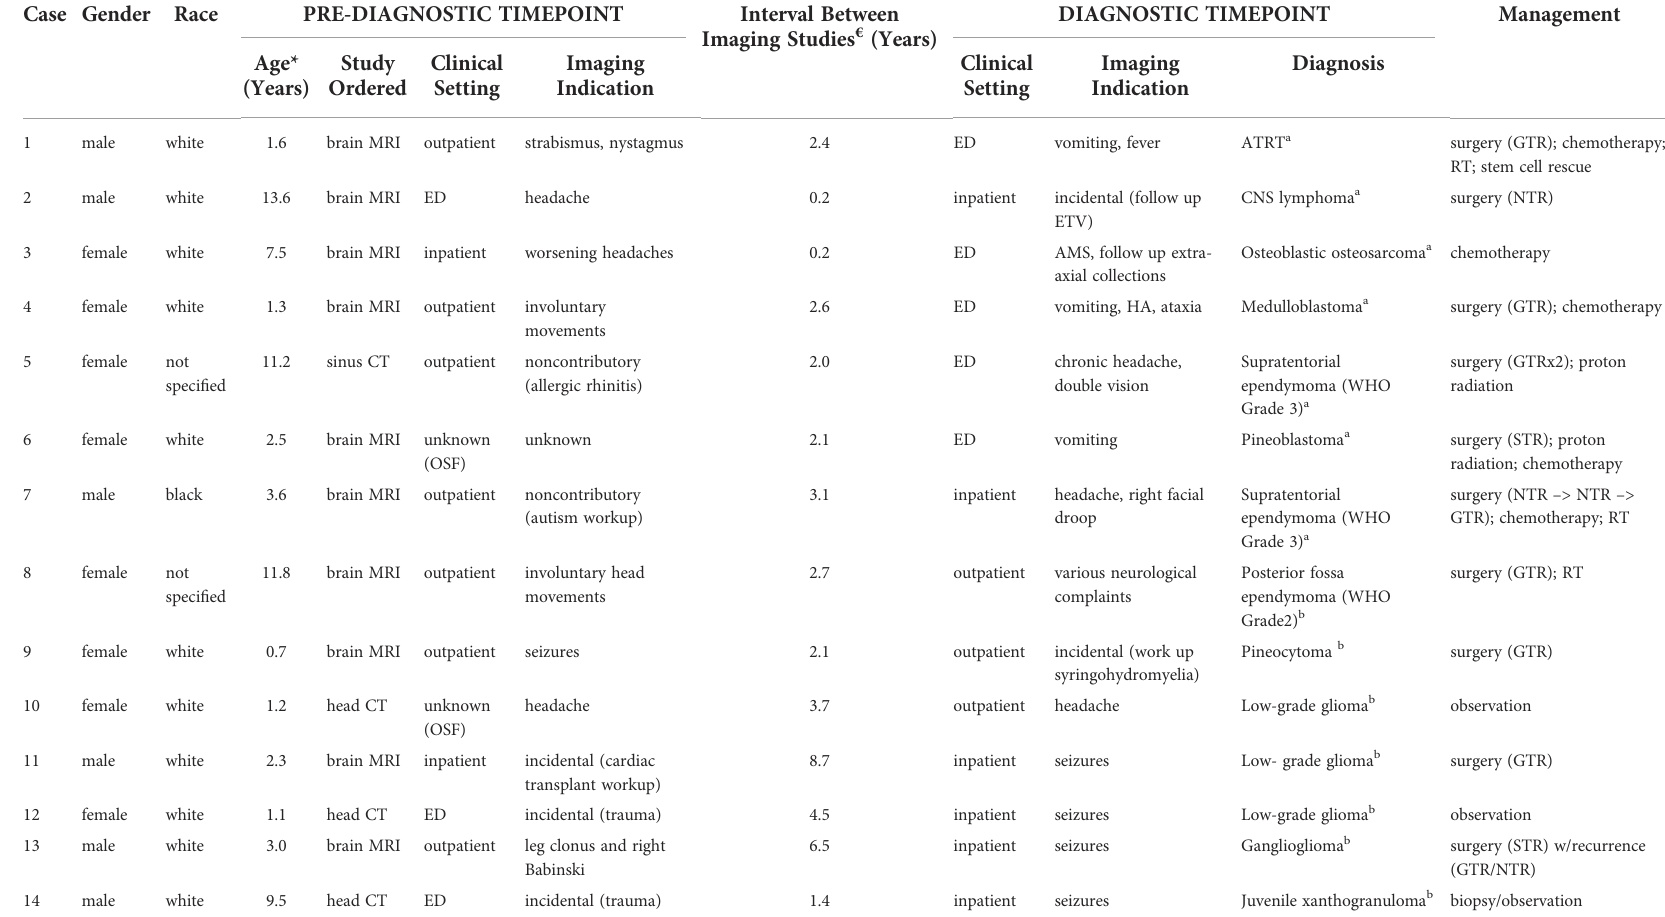
TABLE 1 Patient Demographic and Clinical